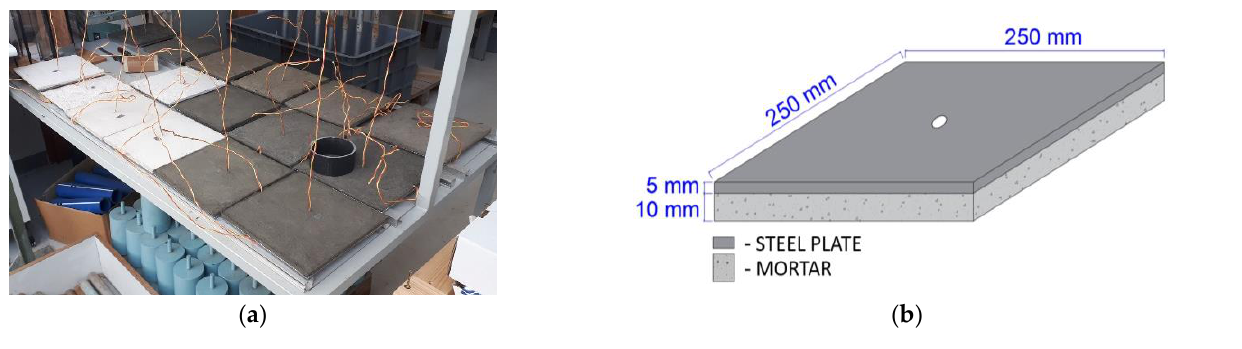
Figure 3. ( a ) Specimens in the process of curing; ( b ) specimen schematic representation and respective dimensions.